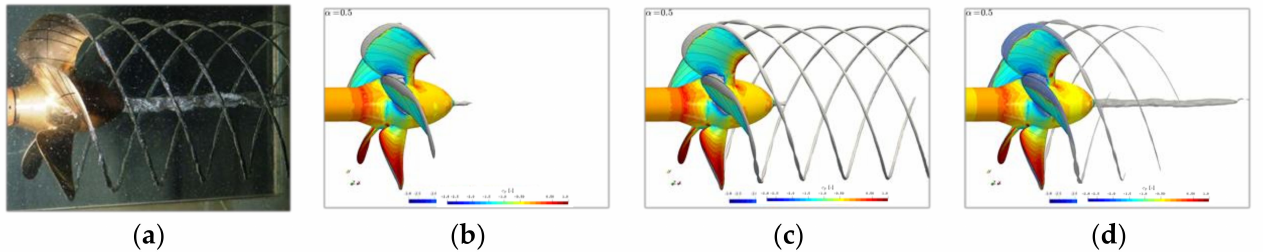
Figure 4. PPTC’11. ( a ) Experiment, reproduced from [26], with permission from SVA Potsdam, 2021; ( b ) initial mesh; ( c ) mesh refinement 1; ( d ) mesh refinement